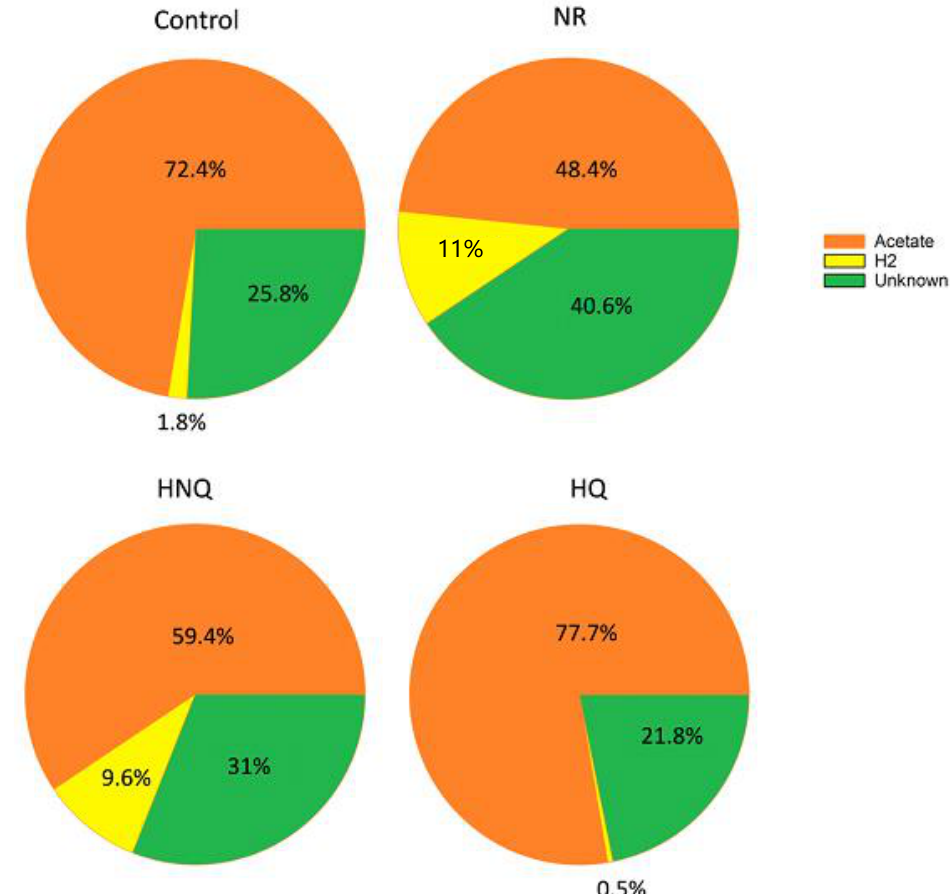
Figure 4. Average electrons accumulated in acetate and hydrogen at 0.1 mM redox mediators from the second to the eighth